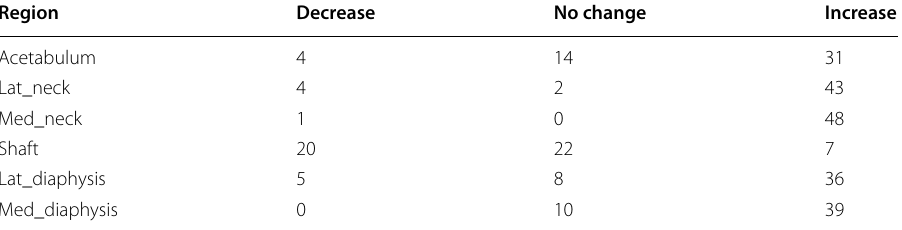
The numbers correspond to the numbers of patients in whom a given change occurs in a given region lat_neck lateral neck region; med_neck medial neck region; lat_diaphysis lateral diaphysis region; med_diaphysis medial diaphysis region